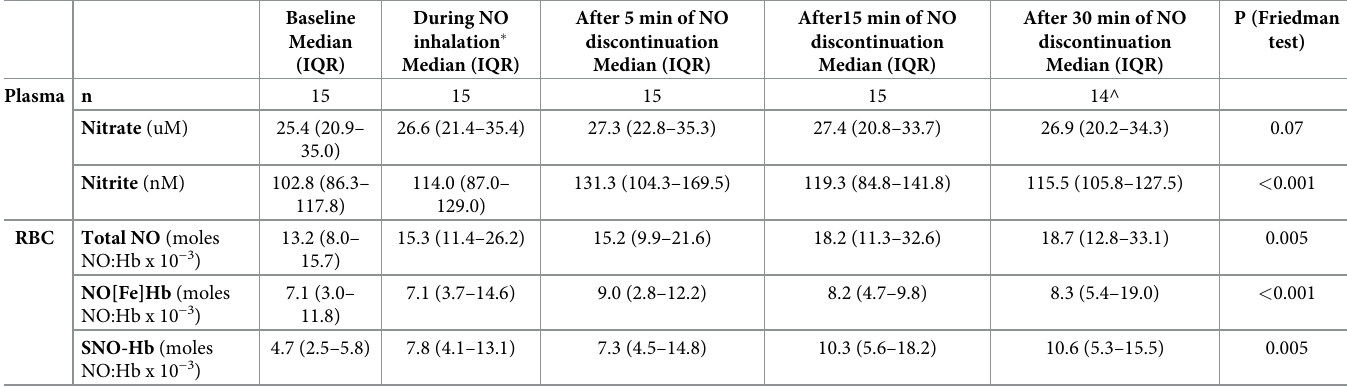
Table 1. Determinations of NO metabolites in plasma and